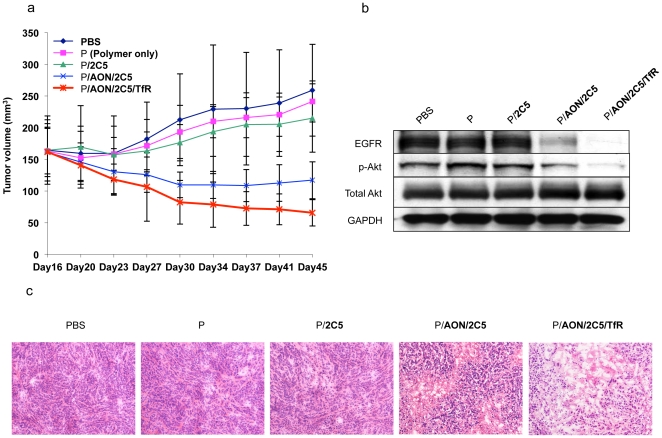
Tumor inhibition in mouse model, and effects on EGFR expression and Akt phosphorylation.(5a) Tumor growth inhibition in mice. MDA-MB-468 subcutaneous breast tumors treated systemically with P/AON/2C5, or P/AON/2C5/TfR were significantly inhibited compared with PBS (control), P(polymer only), or P/2C5 (without anti-tumor component) (P<0.03). The highest inhibition of tumor growth was observed in mice treated with P/AON/2C5/TfR (p<0.03 vs. controls; p<0.05 vs. P/AON/2C5). Error bars denote SEM. (5b) Expression of EGFR and phosphorylated Akt (p-Akt) after treatment of EGFR-positive tumors in vivo. Western blot analysis showed the decrease in EGFR and p-Akt expression in P/AON/2C5-, or P/AON/2C5/TfR -treated mice compared to controls. The highest inhibition of EGFR and p-Akt was seen upon treatment with P/AON/2C5/TfR where 2 targeting antibodies were combined. GAPDH was an internal control to normalize gel loading. (5c) Histopathological analysis of tumors. Hematoxylin and eosin staining of tumors treated with PBS, P, P/2C5, P/AON/2C5 or the leading drug P/AON/2C5/TfR. Consistent with tumor size reduction data, the leading drug P/AON/2C5/TfR treated tumor showed significant reduction in the number of viable tumor cells as compared to other treatments.